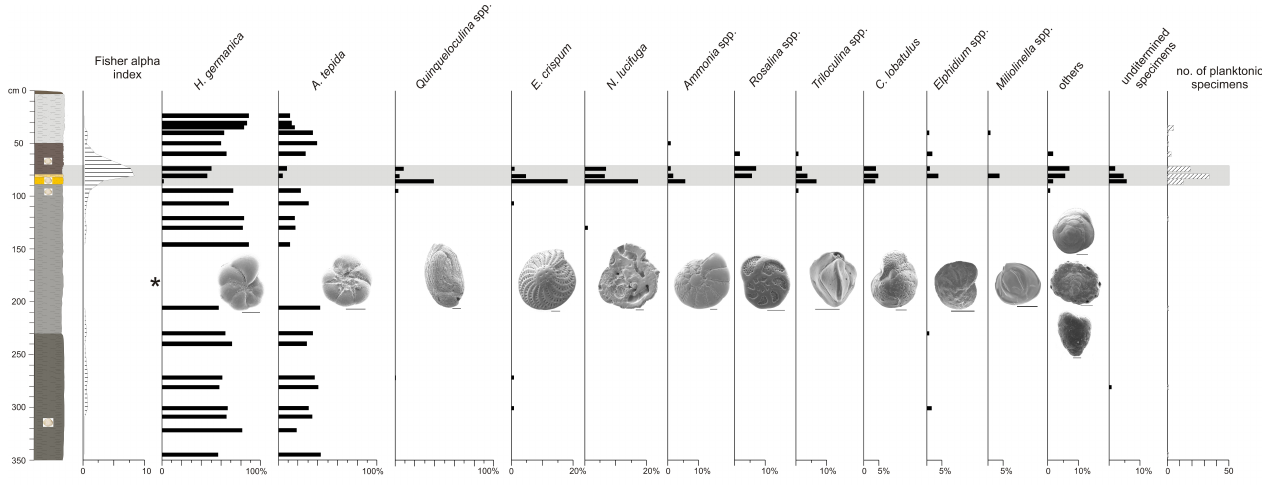
Fig. 6. Benthic foraminifera abundance data (expressed as relative frequency of the total assemblage), the Fisher alpha index plot and the total number of planktonic foraminifera per sample from the western part of Pantano Morghella (core S12, see Fig. 2 for location). The star marks a sample by which the foraminifera concentration was not sufficient to reach 100 specimens. Scanning electron micrographs (bar length = 100µm) of selected species (from the left Haynesina germanica (Ehrenberg), Ammonia tepida (Cushman), Quinqueloculina poeyana d’Orbigny, Elphidium crispum (Linnaeus), Nubecularia lucifuga Defrance, Ammonia parkinsoniana ( d’Orbigny), Rosalina bradyi (Cushman), Triloculina tricarinata d’Orbigny, Cibicides lobatulus (Walker and Jacob), Elphidium sp., Miliolinella semicostata (Wiesner) As- terigerinata mamilla (Williamson), Sorites orbicularis (Forsk˚al), Textularia sp.). The gray horizontal bar indicates those samples influenced by the deposition of the MOR-T02 layer. For the legend of the core see Fig.